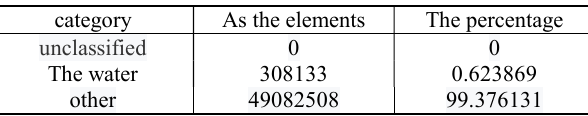
Table 4-3 Statistical results of surface water distribution in Guilin in 2016